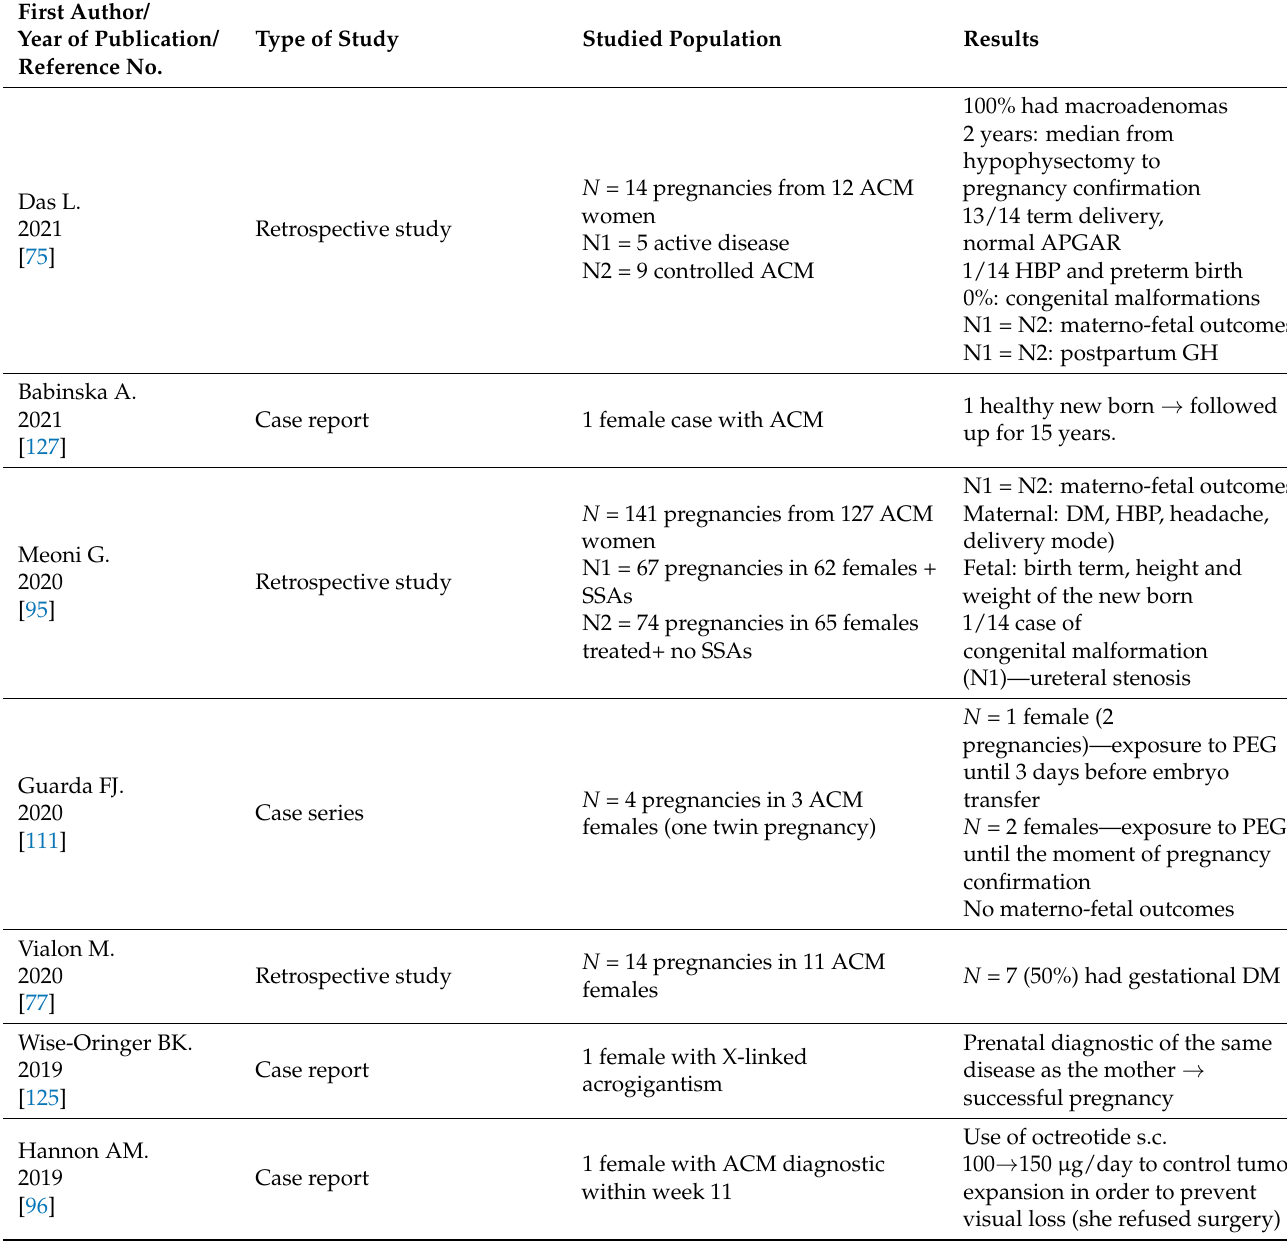
Table 1. Studies on acromegaly and pregnancy that are published according to our methodology; we only included the studies concerning female acromegalic subjects, not other pituitary tumors; the order of display is based on publication date starting with the most recent (please see